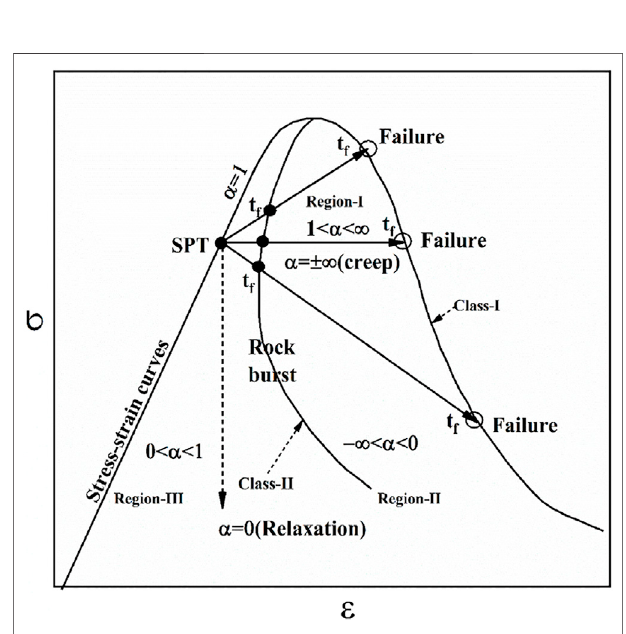
FIGURE 8 | Complete generalized relaxation curves of granite: (A) Generalized relaxation behaviors of granite, (B) Δ σ and Δ ε varied with time of α (cid:2) − 3.